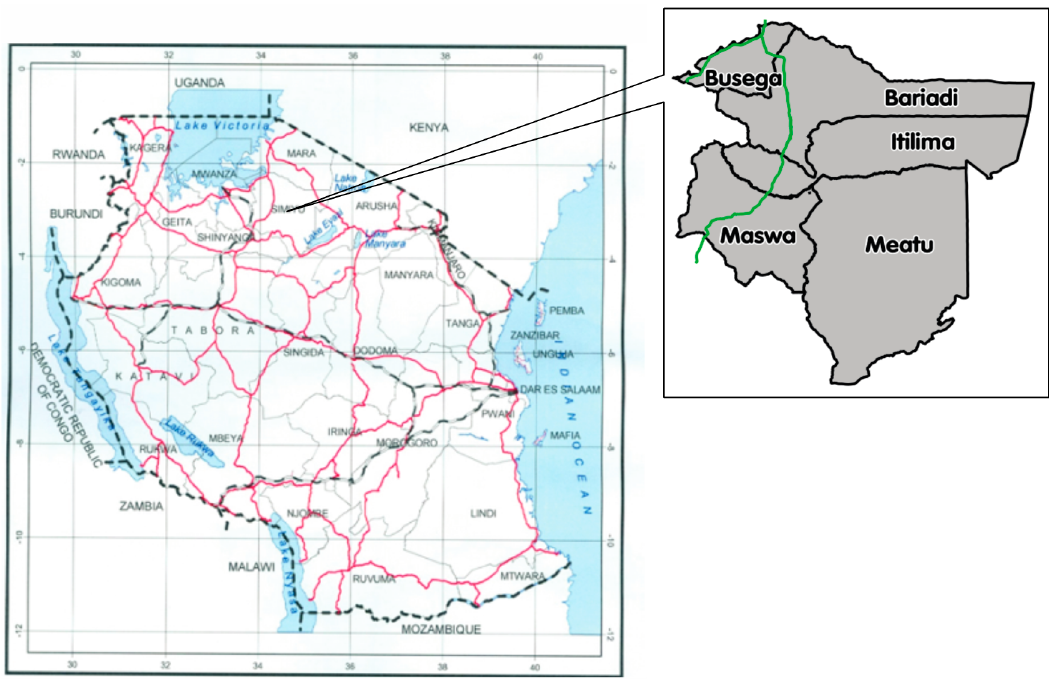
Figure 1. Map of Tanzania showing the study area [20].